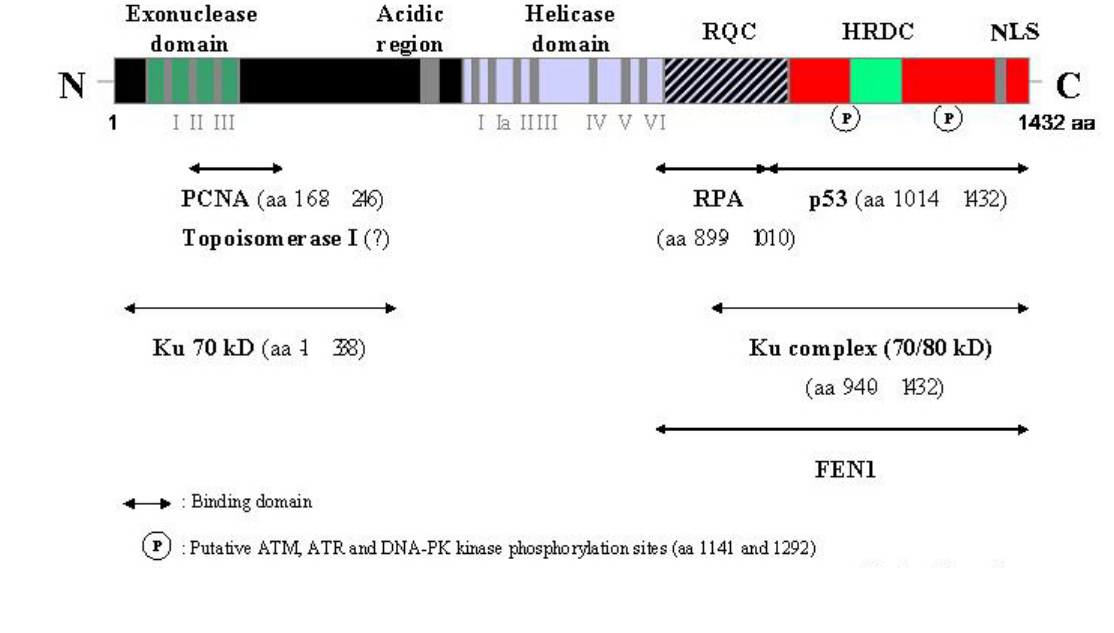
FIGURE 1. Werner protein interactors.